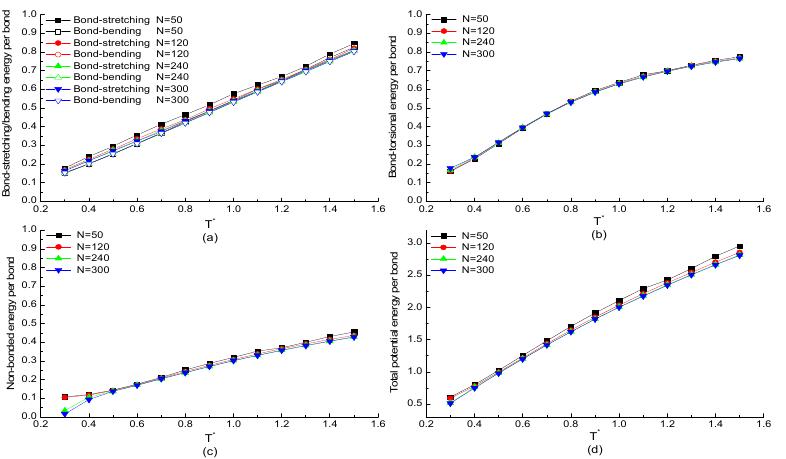
Figure 1. The temperature dependencies of the potential energies ( a ) bond-stretching/bending energy, ( b ) bond-torsional energy, ( c ) non-bonded energy, ( d ) total potential energy of each bond in H3N1P1 proteins with different chain